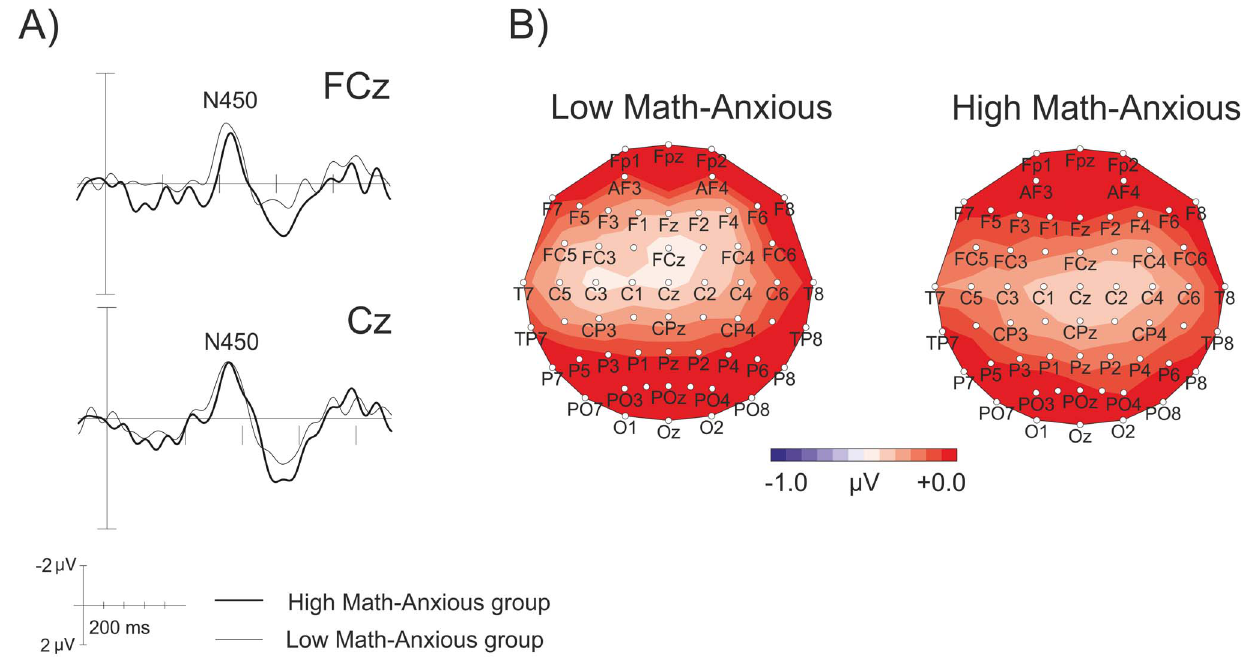
Figure 2. Grand average waveforms at FCz and Cz for the N450 component, showing the interference effect (incongruent- congruent) in the LMA and HMA groups (A); and the scalp topography of the N450 component, showing the interference effect in the 350–500 ms window for the LMA and HMA groups (B).